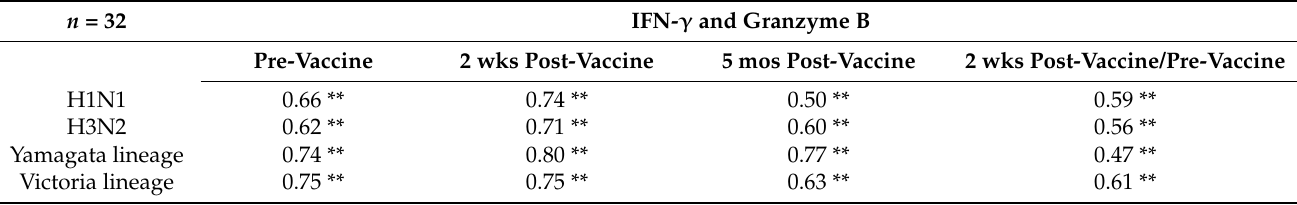
Table 2. Spearman’s correlation coefficients assessing the relationship between IFN- γ and granzyme B levels before and after